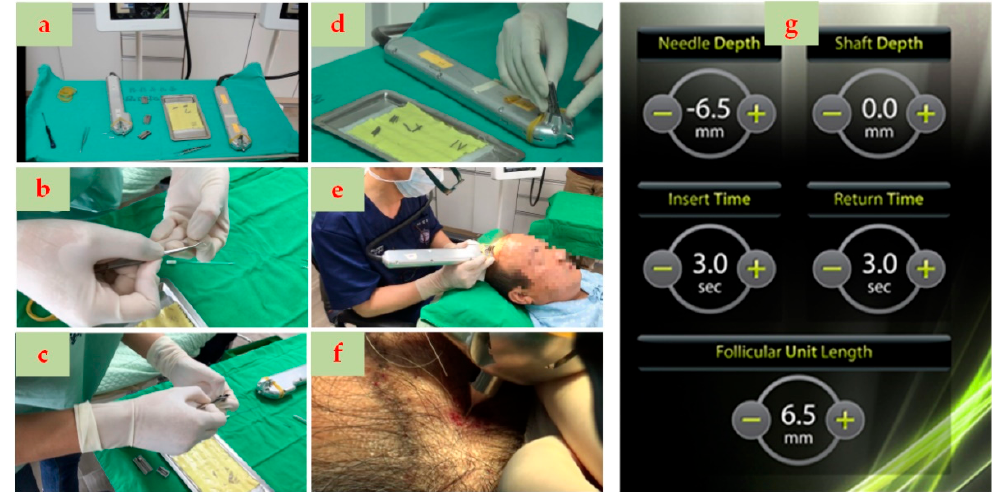
Figure 14. Procedure of the clinical experiment using the semi-automatic implanter. ( a ) Deploying the semi-automatic implanter, ( b ) loading a HF in a needle, ( c ) inserting an HF-loaded needle into the NSM, ( d ) mounting the NSM on the semi-automatic implanter, ( e ) gripping the semi-automatic implanter, ( f ) transplantation, and ( g ) control software GUI.